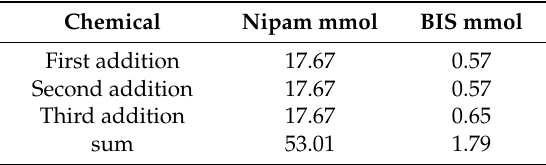
Table 2. Amounts of the chemicals used for the synthesis of SiPn-3 (a–c). Methylene-bis-acrylamide